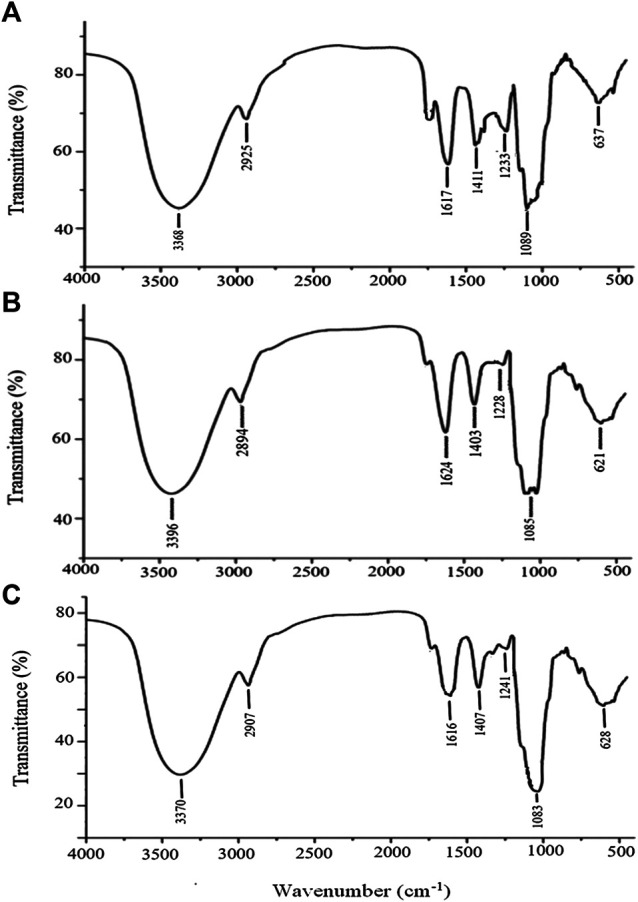
FT-IR analysis of APS-Ⅰ (A), APS-Ⅱ (B) and APS-Ⅲ (C).